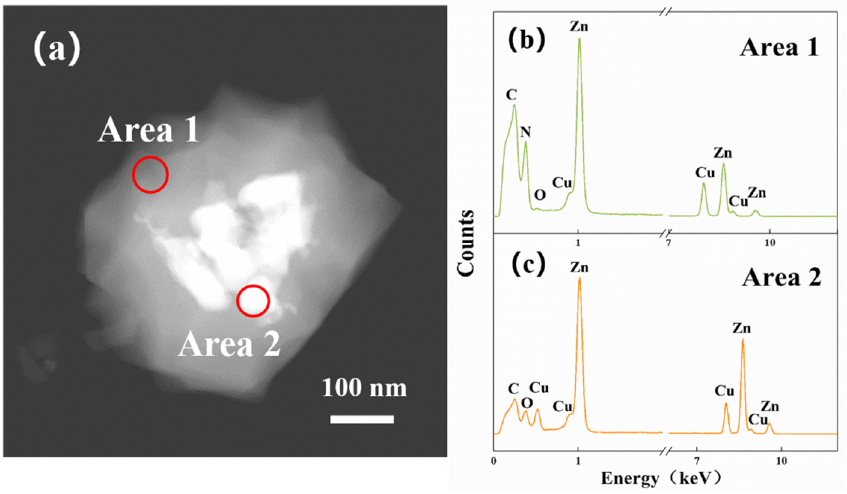
Figure 8. TEM image of 20-ZnO@ZIF-8 ( a ) and elemental energy spectrum of the shell ( b ) and the core ( c ) .